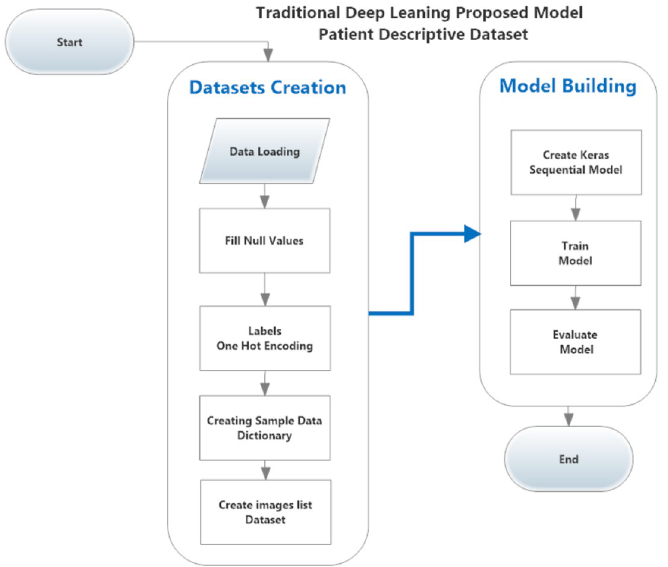
Fig 5. The proposed traditional model for classifying COVID-19 cases from patient’s descriptive dataset.